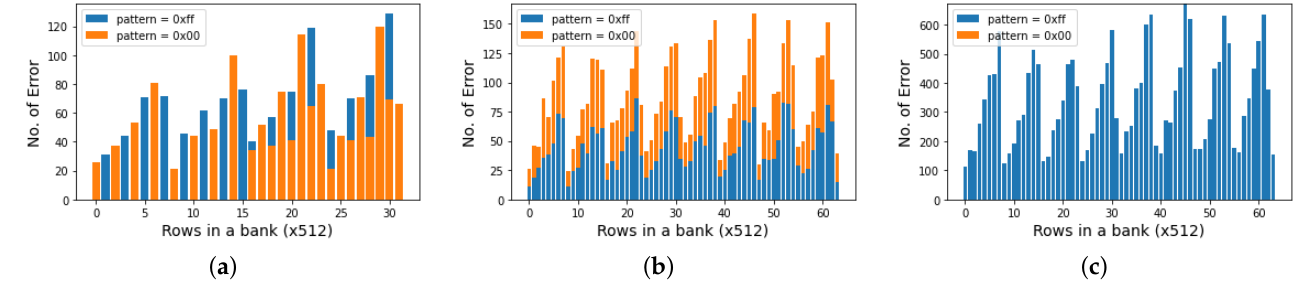
Figure 5. Retention error in a module increases periodically across the row due to design variations. ( a ) Retention error ( t ret = 20 s) in a Micron 1 GB DRAM module. ( b ) Retention error ( t ret = 20 s) in a Hynix 2 GB DRAM module. ( c ) Retention error ( t ret = 20 s) in a Samsung 2 GB DRAM